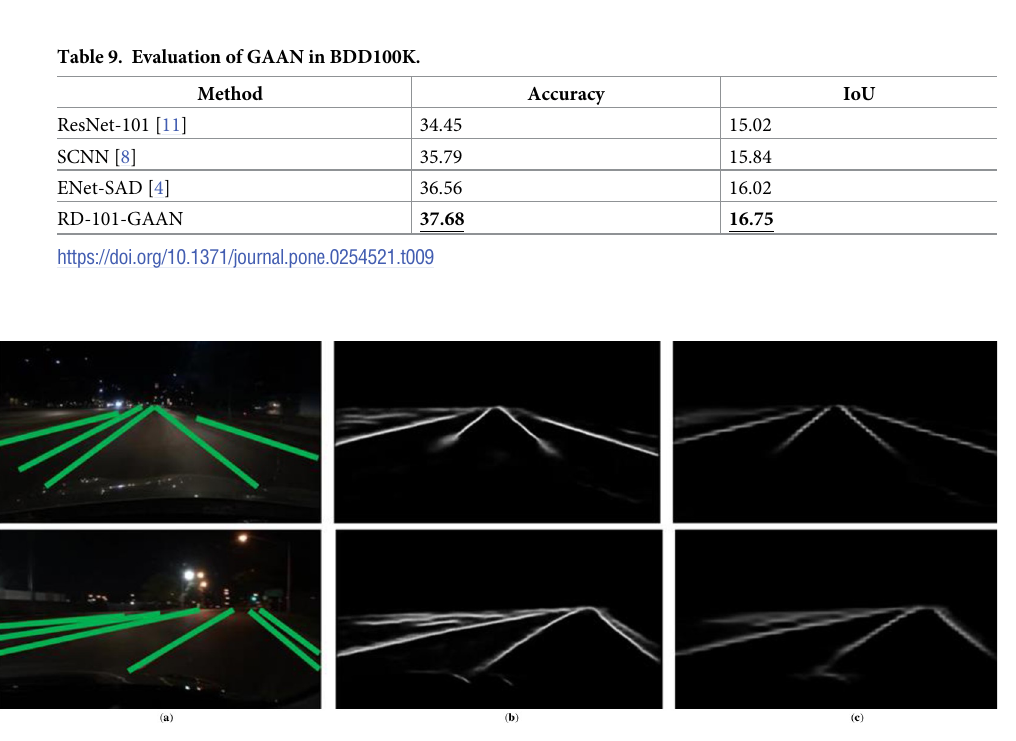
Fig 10. The results of GAAN and SCNN in BDD100K: ( a ) Input and GT; ( b ) GAAN; ( c ) SCNN.